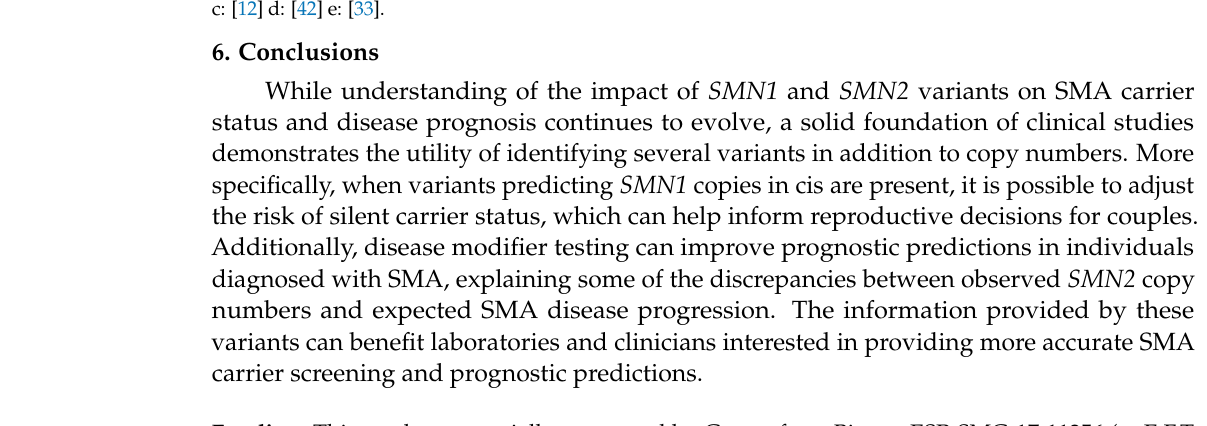
Refer to other examples with negative c.859G>C variant status for example